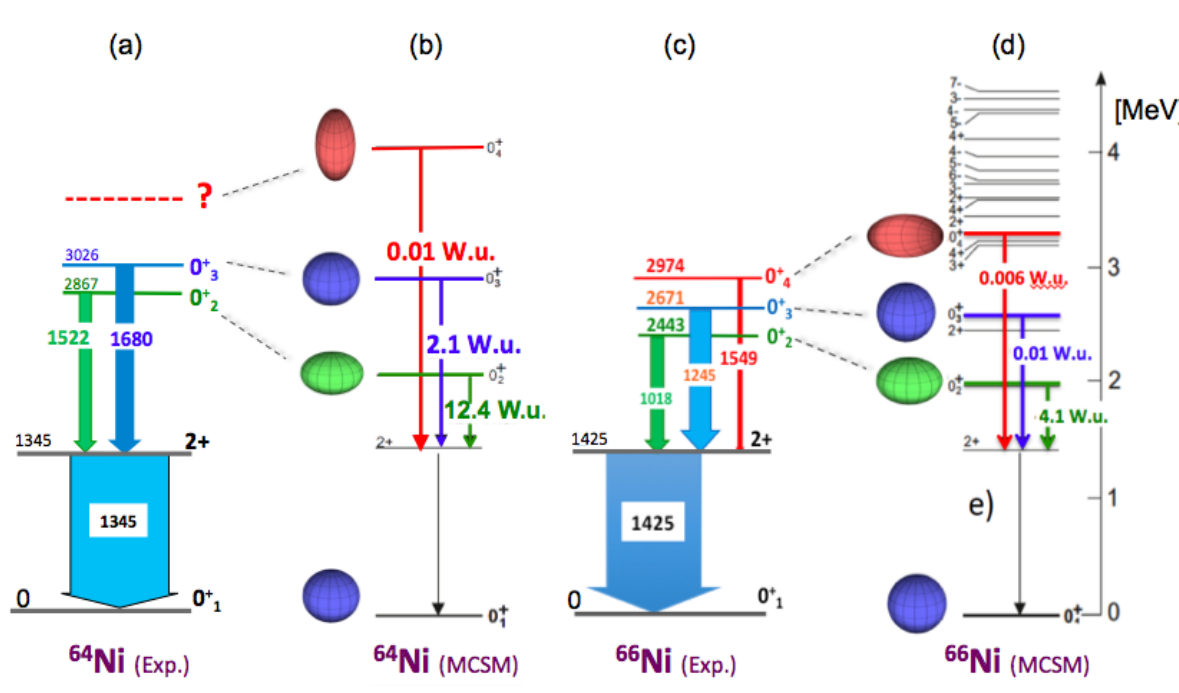
Figure 2. Partial level schemes of 64 Ni (a) and 66 Ni (c), focusing on the decay from 0 + states, as observed experimentally. Corresponding calculations from Monte Carlo Shell Model are shown in (b) and (c), with cartoons indicating the predicted intrinsic shape for the 0 + states (i.e., spherical (blue), oblate (green) and prolate (red)). Calculated B(E2) values from each 0 + excitation to the first excited 2 + state are also given in Weisskopf units